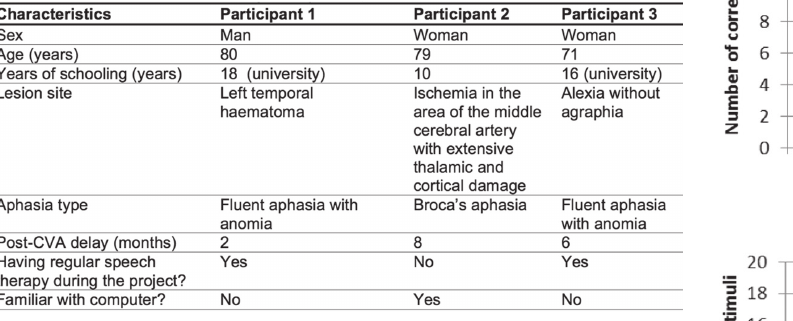
Table 2: Characteristics of the participants